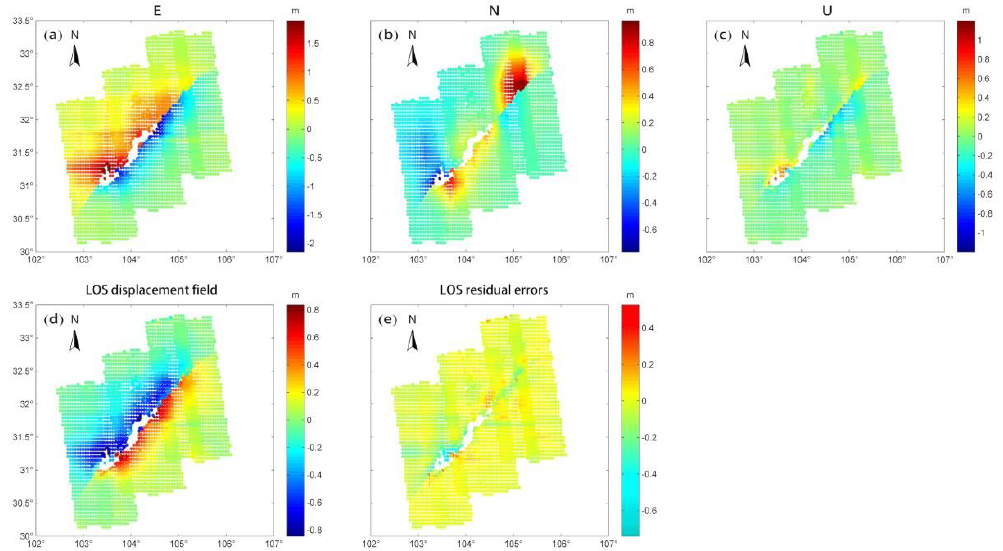
Figure 11. The results obtained by the direct solution method, ( a ), ( b ), and ( c ) are the deformations of E, N, and U directions, respectively. ( d ) is the modelled LOS displacement field. ( e ) are the residual errors between the modelled and observed LOS displacements.